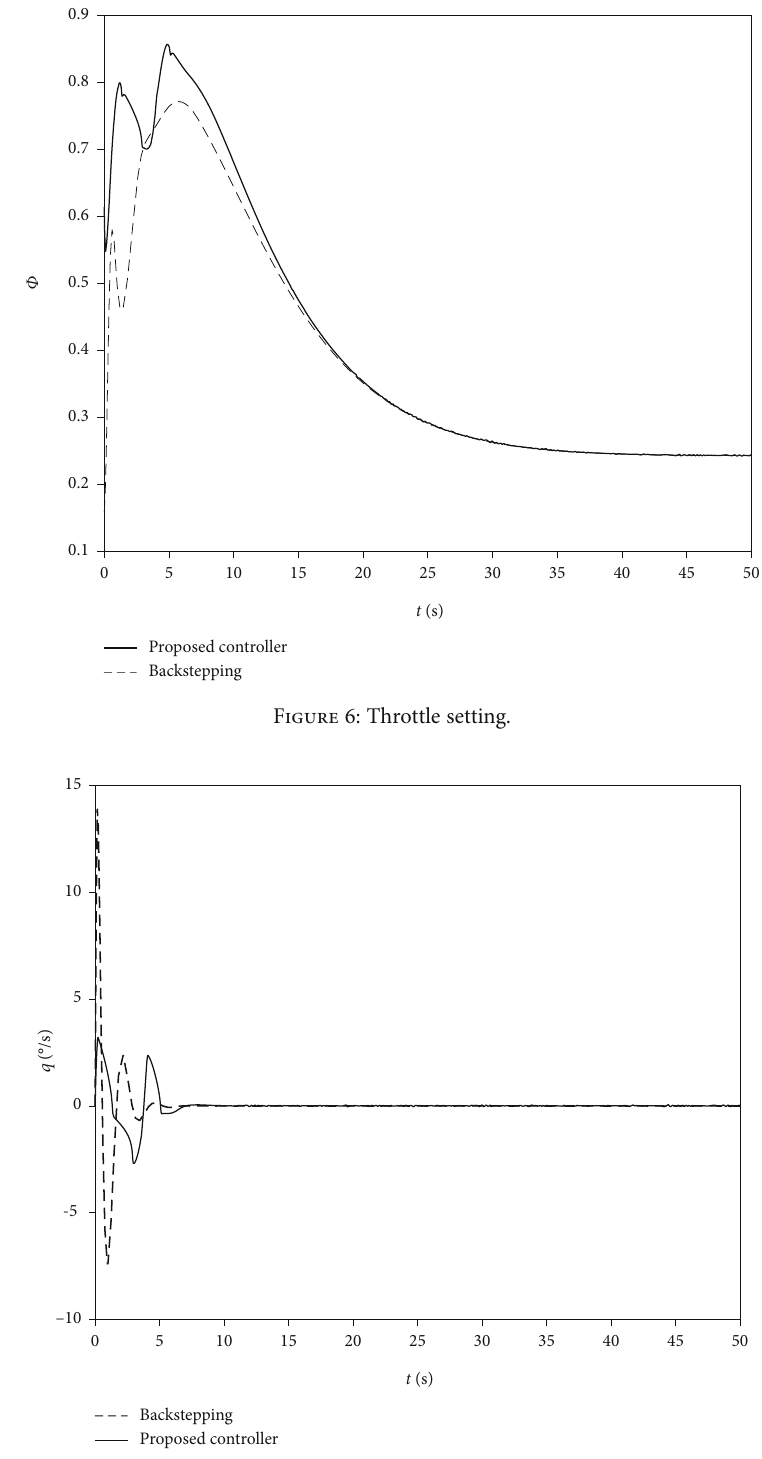
Figure 7: Pitching angle